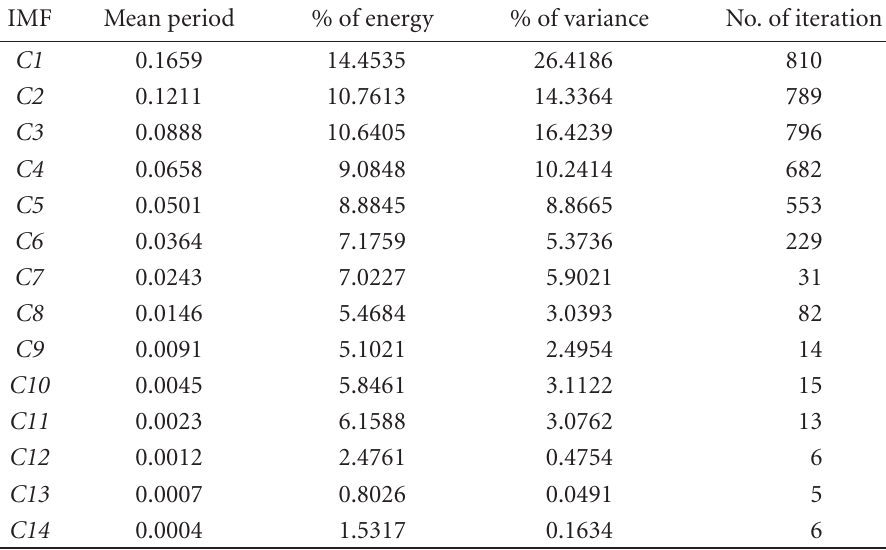
Figure 3.9. Degree of stationarity of the rainfall data (with 256 frequency bins). Table 3.1. Some valuable parameters of IMF